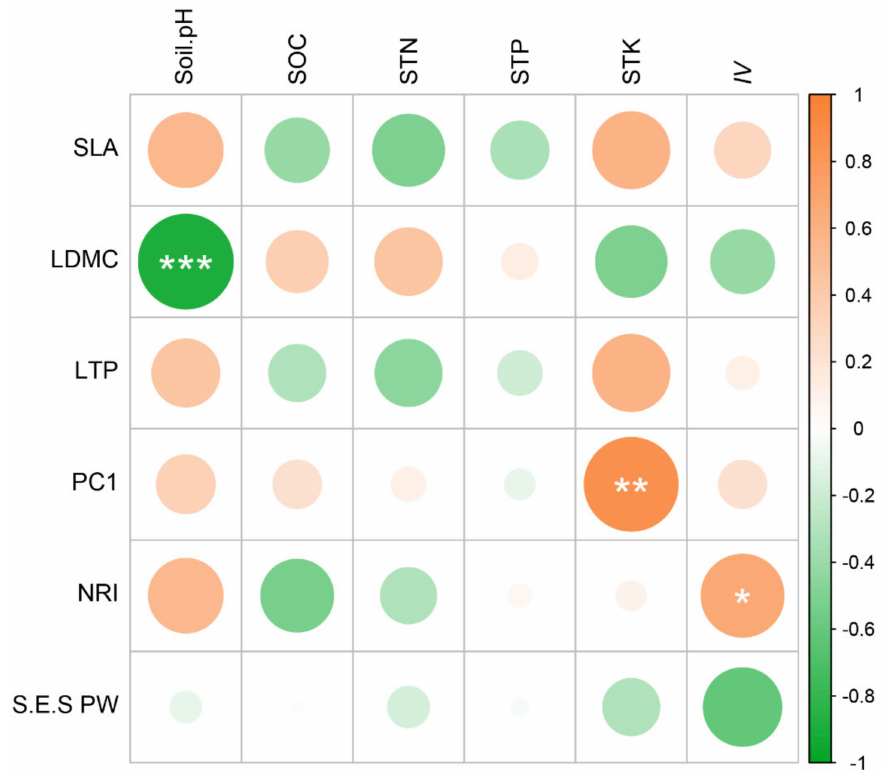
Figure 5. Pearson correlation among the LES traits, PC1, NRI, S.E.S PW, soil factors, and IV in the whole habitats. “*” means significant correlation ( p < 0.05), “**” and “***” means extremely significant correlation ( p <